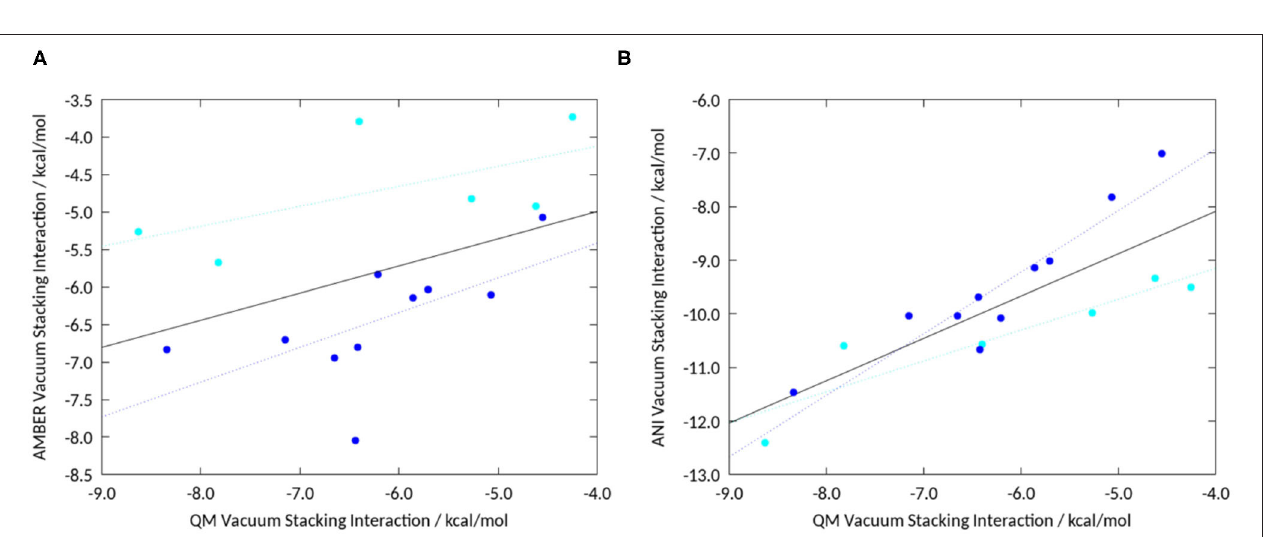
FIGURE 4 | (A) Vacuum stacking interactions from geometry optimizations using GAFF correlated with high-level QM calculations. Overall the Pearson correlation is 0.41. (B) Correlation of stacking interaction energies calculated from geometry optimizations using ANI with published unrestrained geometry optimizations using high-level QM calculations (Loeffler et al., 2020). Shown in dark blue are the 6-membered rings, and in cyan the 5-membered heteroaromatics. We find an overall correlation of 0.81, the linear fit for all complexes is shown in black. The linear fit for the individual groups of compounds are shown in dark blue for the 6-membered rings and in cyan for the 5-membered rings,